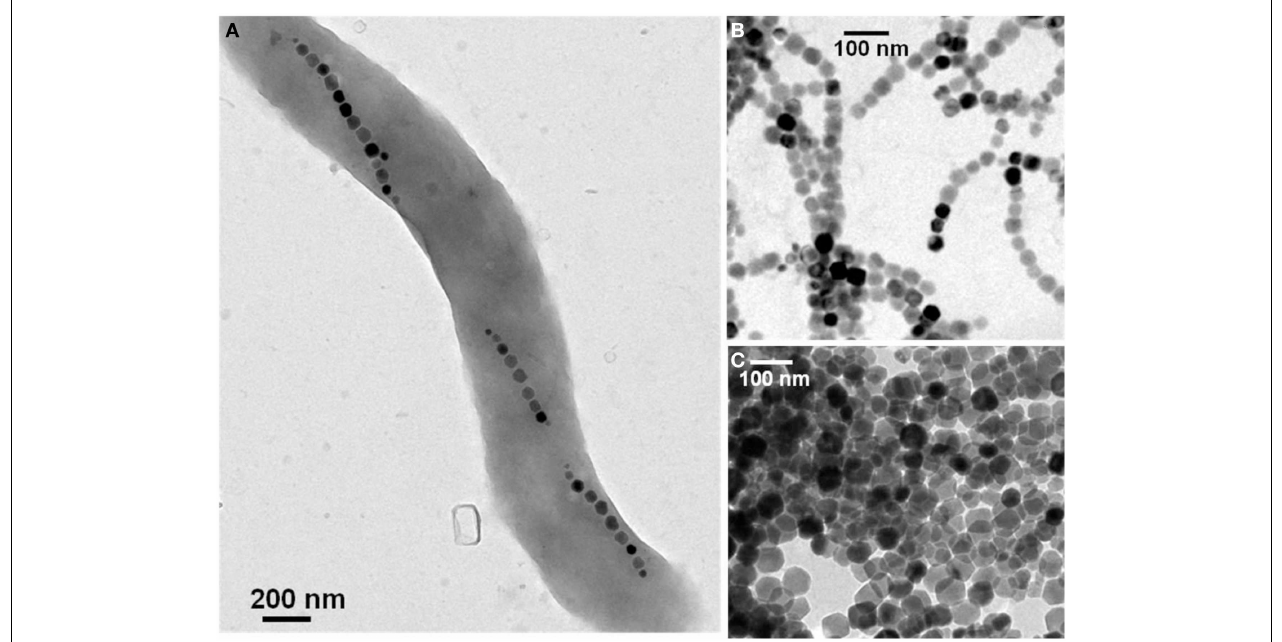
FIGURE 1 |Transmission electron microscopy images of a single magnetotactic bacterium (A) of chains of magnetosomes extracted from whole magnetotactic bacteria (B) of individual magnetosomes detached from the chains by heat and SDS treatment (C) .